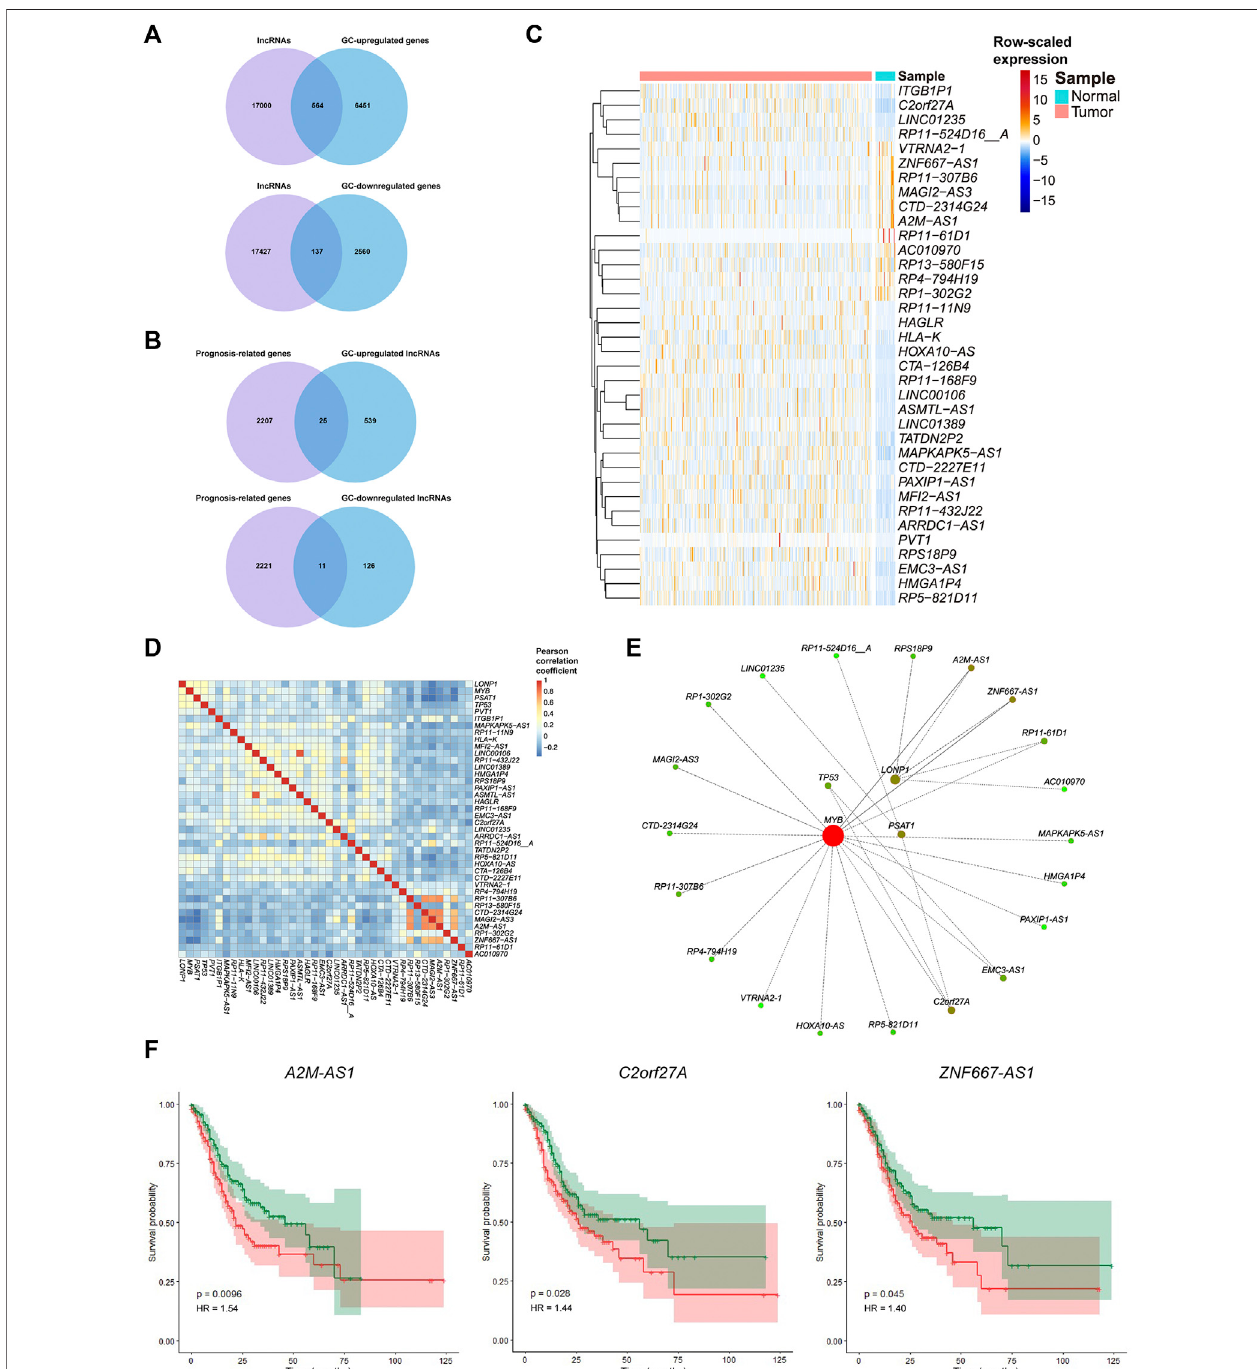
FIGURE 6 | Relationships of the expression of the hub FRGs and their correlated lncRNAs involved in tumorigenesis and prognosis of GC. (A) Venn diagram representationoflncRNAsobtainedfromGENCODE(version25)andDEGsbetweenGCsamplesandadjacentcancersamplesintheTCGAdataset. (B) Venndiagram representation of prognosis-related genes and GC-differentially expressed lncRNAs in the TCGA dataset. (C) Heatmap plot for the expression of important lncRNAs in GCsamplesandadjacentcancersamplesintheTCGAdataset. (D) Correlation heatmapforPearson ’ scoef fi cientoftheexpression ofimportant lncRNAsand hub FRGs. (E) Interaction network of important lncRNAs and hub FRGs based on their connectivity. Red represents more connectivity between two genes. (F) K-M survival curves and p -values for the three important lncRNAs ( A2M-AS1 , C2orf27A , and ZNF667-AS1 ). Patients with high or low expression of one of the three lncRNAs are labeled with a red line or green line, respectively.